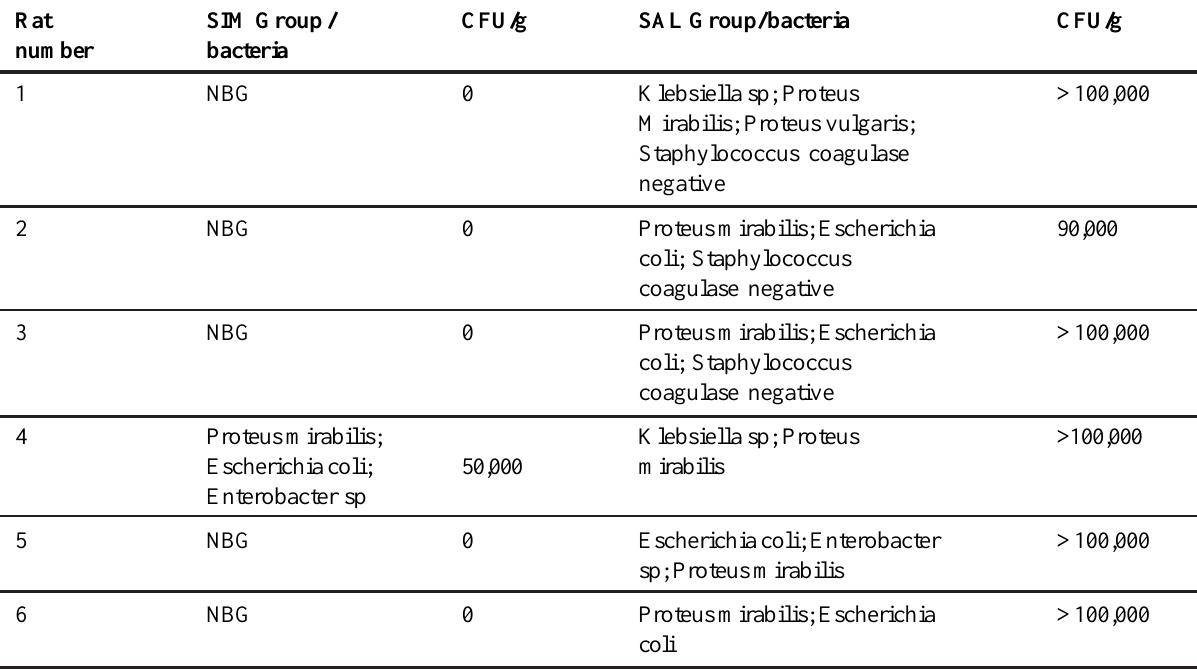
TABLE 3 - Detection of bacteria in the wound fluid of animals in groups treated with simvastatin (SIM) and treated with saline